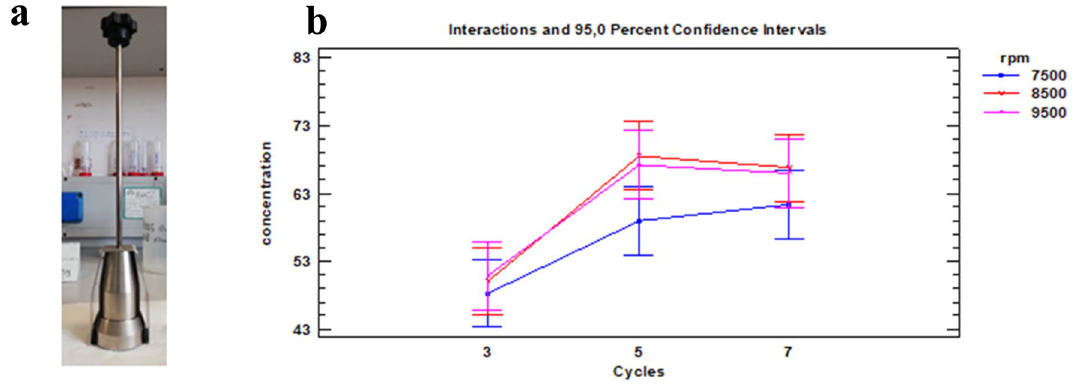
Figure 1. ( a ) Home-made closed stainless-steel mortar; ( b ) Two-way ANOVA interaction plot for homogenization step. Concentration values expressed as µg protein/mg tissue.